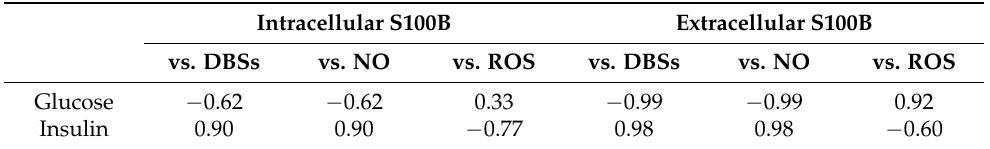
Table 2. Correlations between 100B protein levels and measured parameters: ROS, NO and DBSs in neuron-like cells after glucose or insulin treatment for 24 h. Intracellular